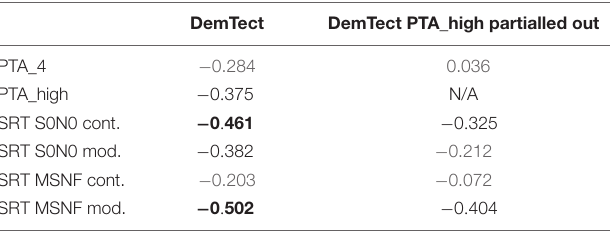
TABLE 2 | Spearman correlation coefficients ρ for results on measures of hearing loss and speech perception in noise vs. DemTect score (first column).